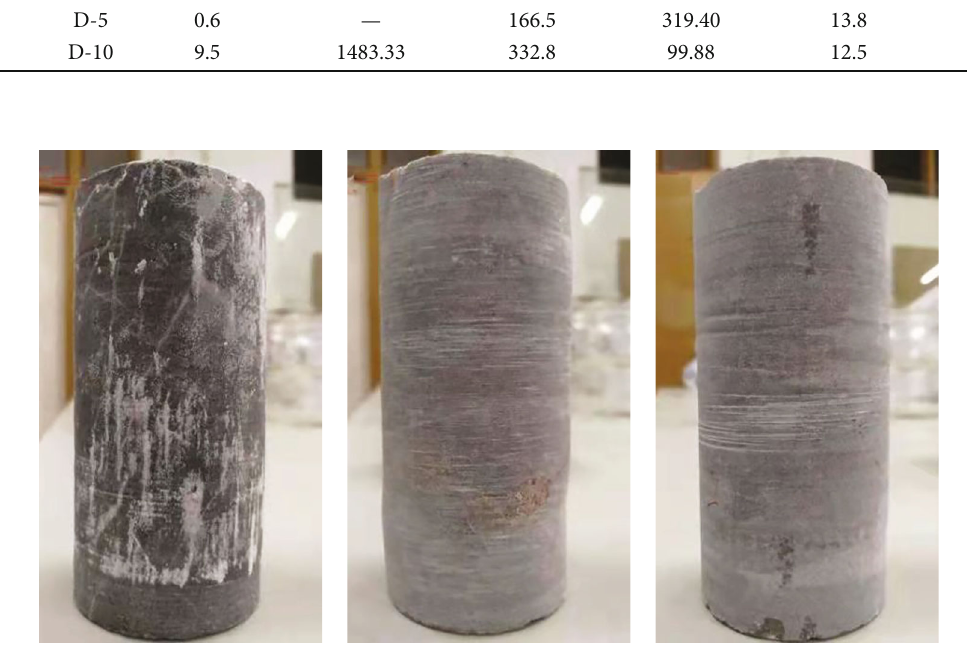
Figure 8: Limestone samples after 10 dry-wet cycles in di ff erent acid